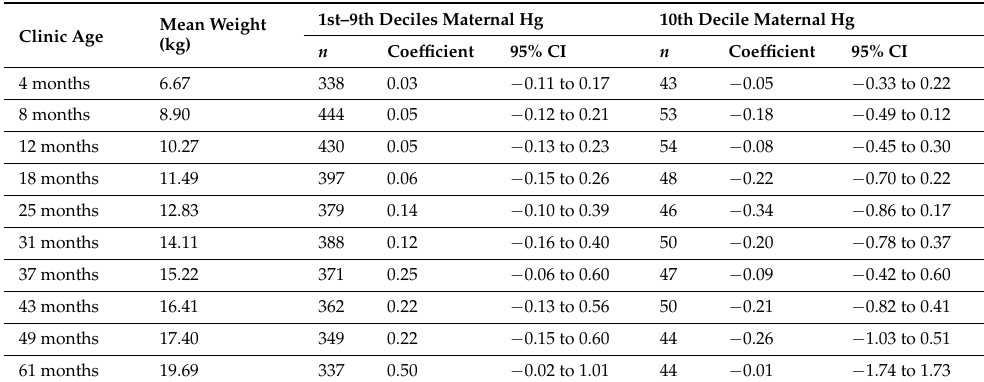
Table 4. Estimated associations between deciles of maternal blood mercury ( µ g/L) and child weight (kg), at 10 clinic